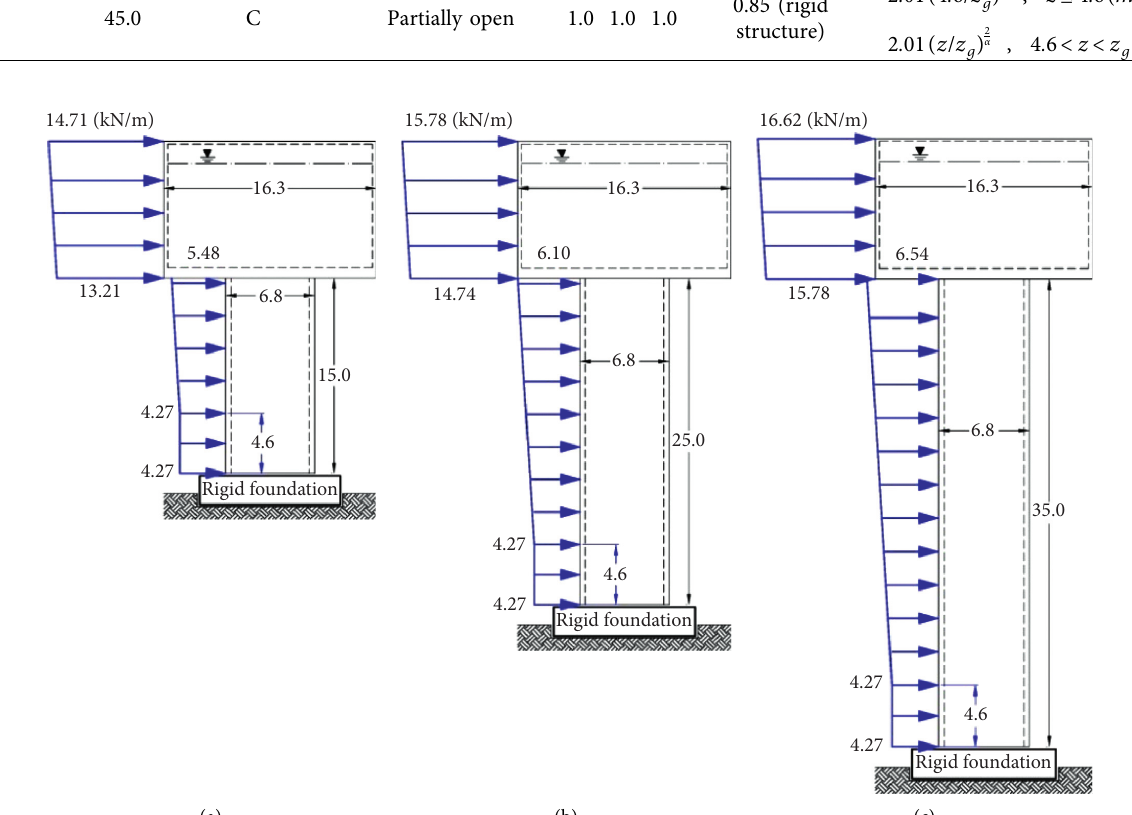
Figure 18: Distributions of design wind load in the height of the prototypes (dimensions are in meters). (a) 15-meter-high shaft. (b) 25- meter-high shaft. (c) 35-meter-high shaft.